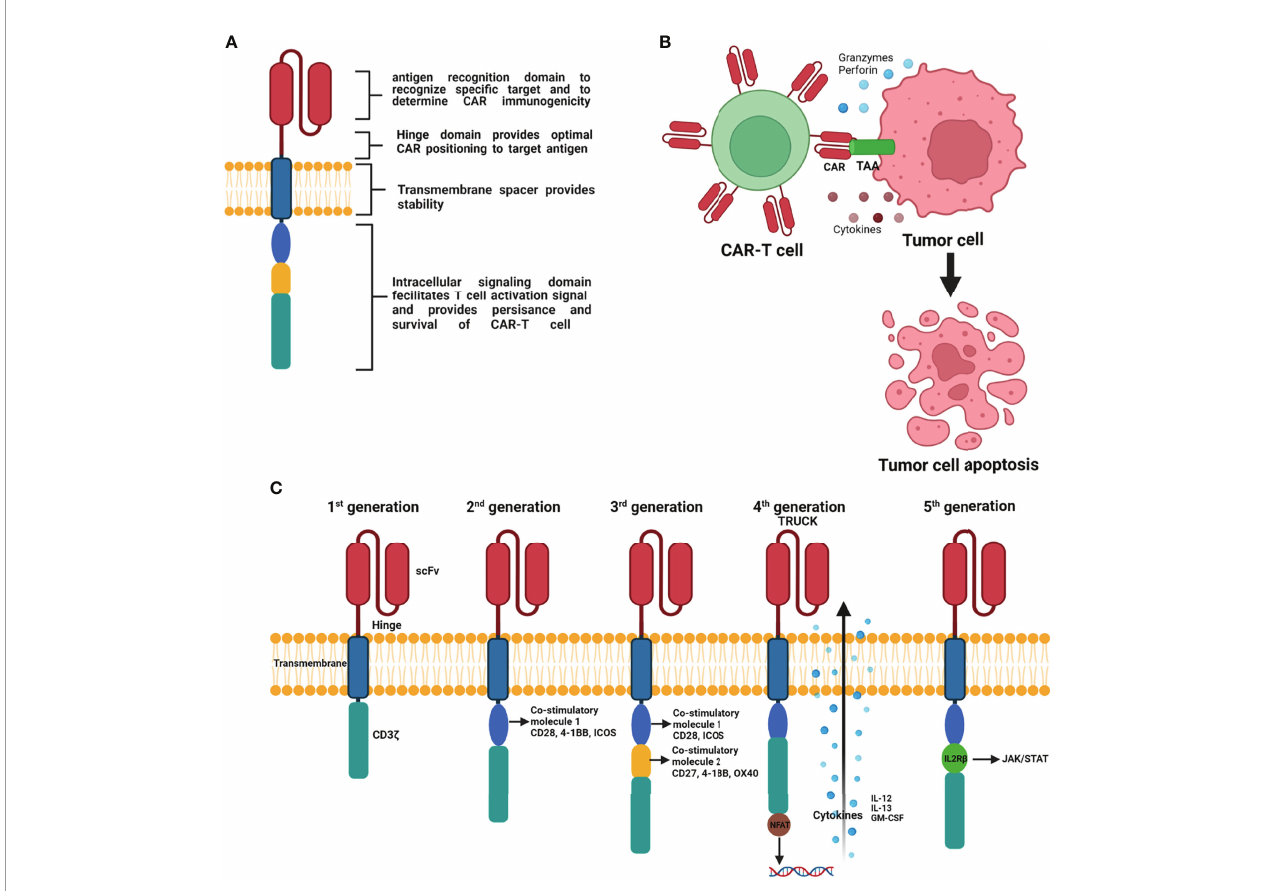
FIGURE 1 | Schematic representation of basic principle of CAR structure (A) , mechanism of CAR engineered T-cells action on tumor cells (B) , and progressive evolution of CAR-T cells with modi fi cations from 1 st generation to 5 th generation (C) (Figure generated using Bio